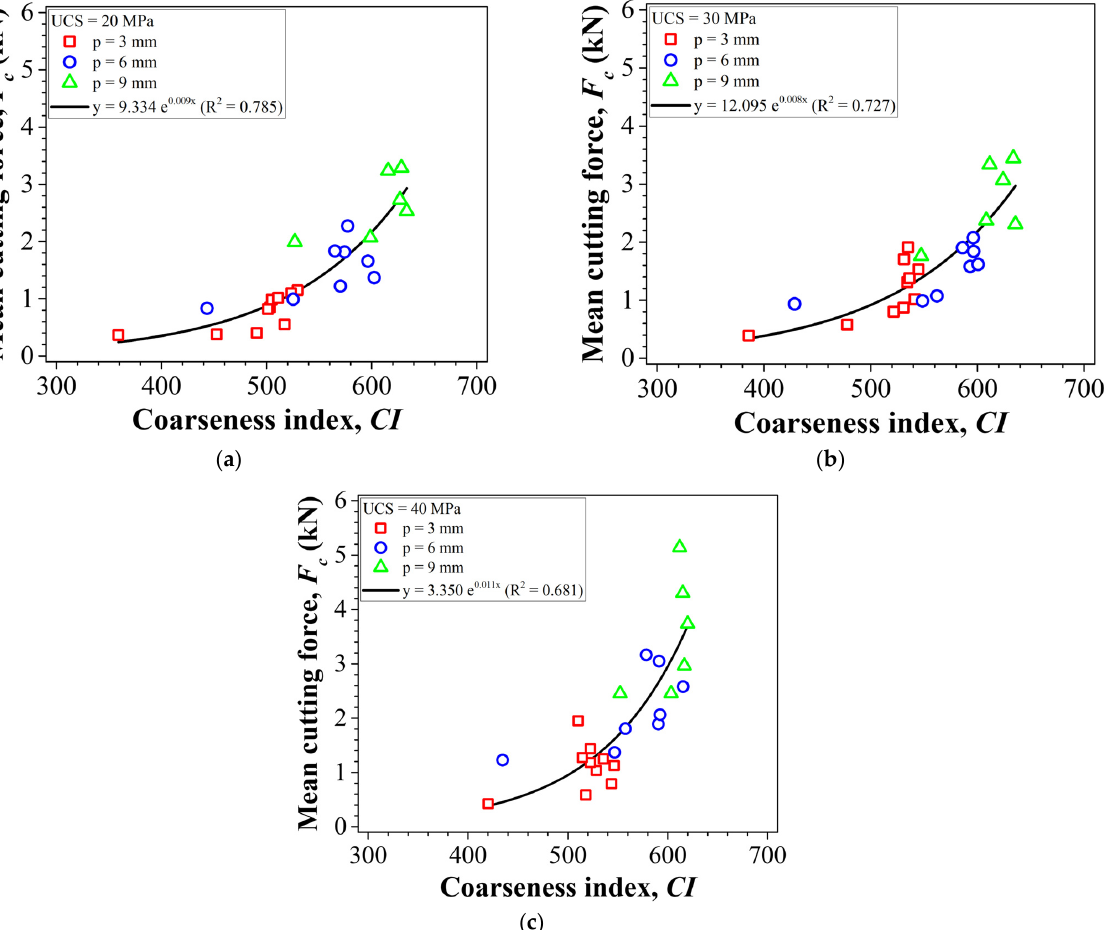
Figure 11. Relationship between CI and mean cutting force: ( a ) rock of UCS 20 MPa; ( b ) rock of UCS 30 MPa; ( c ) rock of UCS 40 MPa.